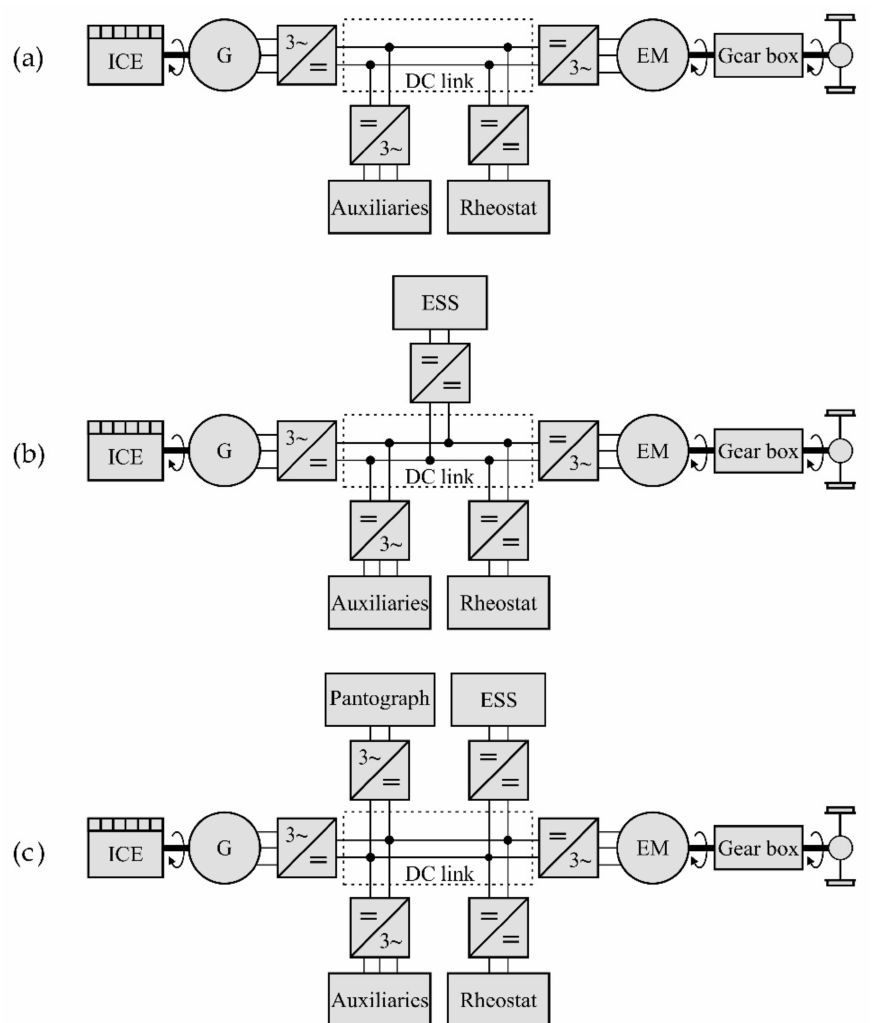
Figure 1. Simplified schematic representation of ( a ) standard, ( b ) hybrid, and ( c ) plug-in hybrid system architectures for a diesel-electric multiple unit